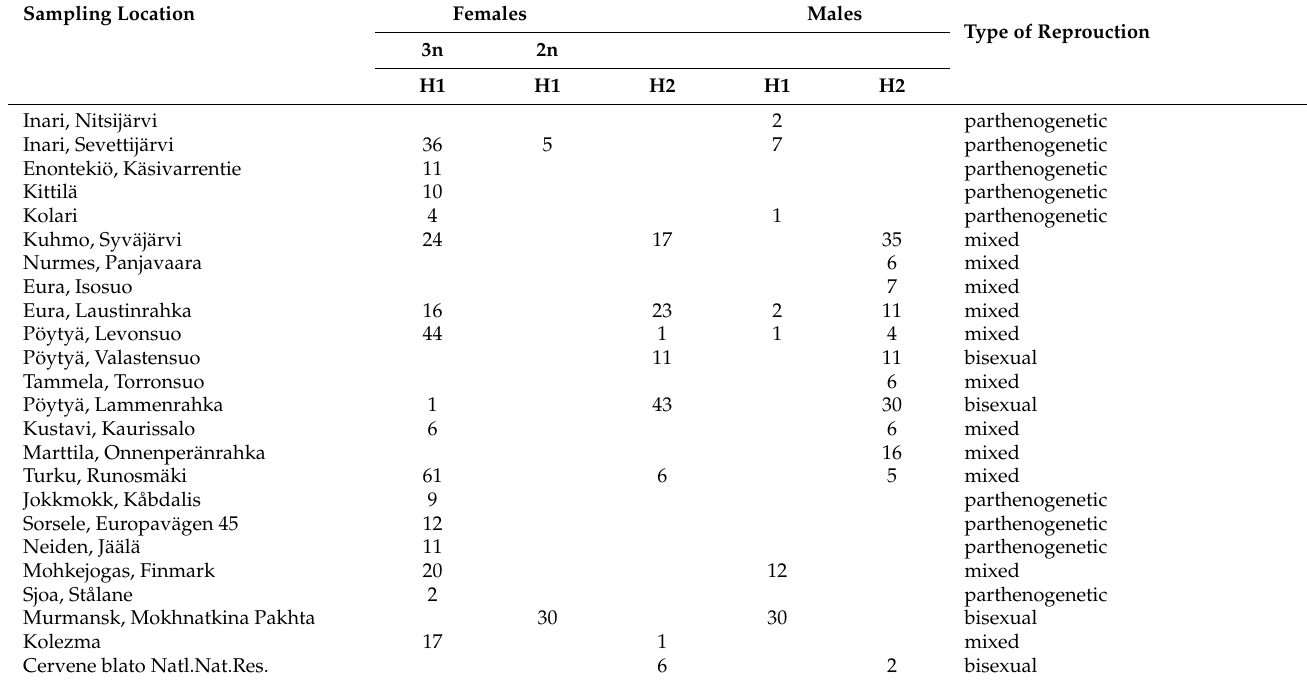
Table 3. The number of individuals carrying haplotypes H1 and H2, and type of reproduction in Cacopsylla ledi samples